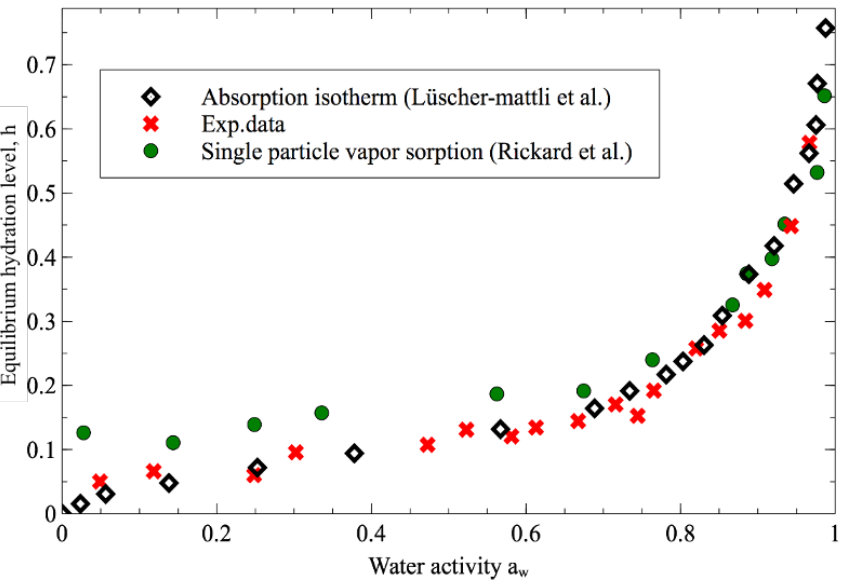
Figure 6. Equilibrium hydration levels at the end of the protein droplets dehydration process using 1-decanol are shown as a function of water activity to other previously published data (data of absorption isotherm obtained from ref [17] and data of single particle vapor sorption from ref. [7]).